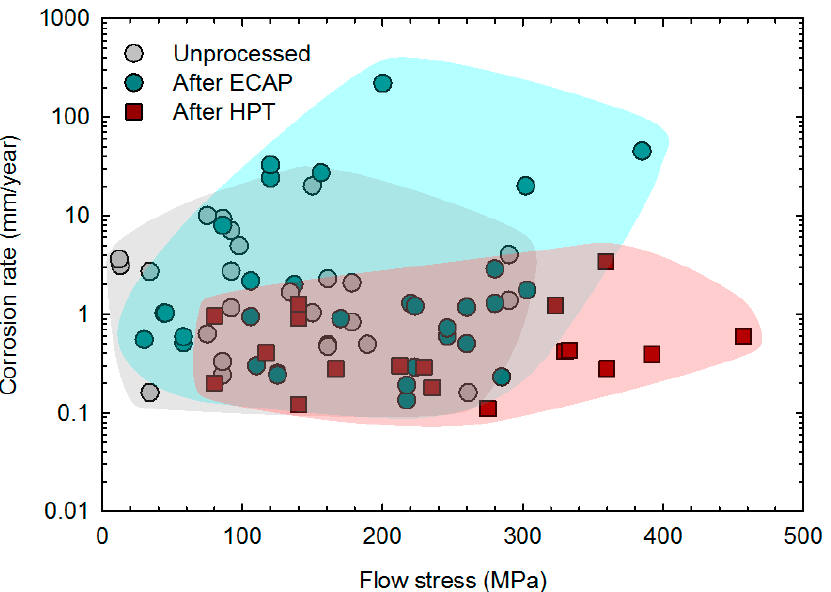
Figure 12. Corrosion rate vs. flow stress of magnesium and its alloys before and after SPD processing. Data from the literature [19,57–59,64,66,70,72,76–80,82–88,90–92,94,100].